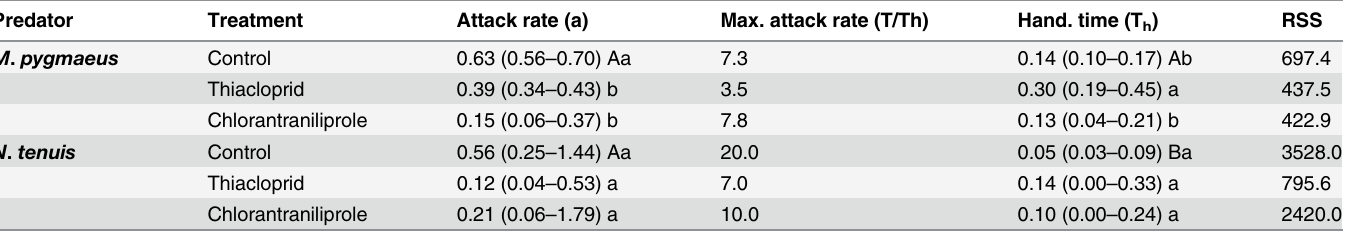
Table 1. Parameters for type II functional response models (mean, 95% CI) * for M . pygmaeus and N . tenuis . RSS is the residual sum of squares of the model.